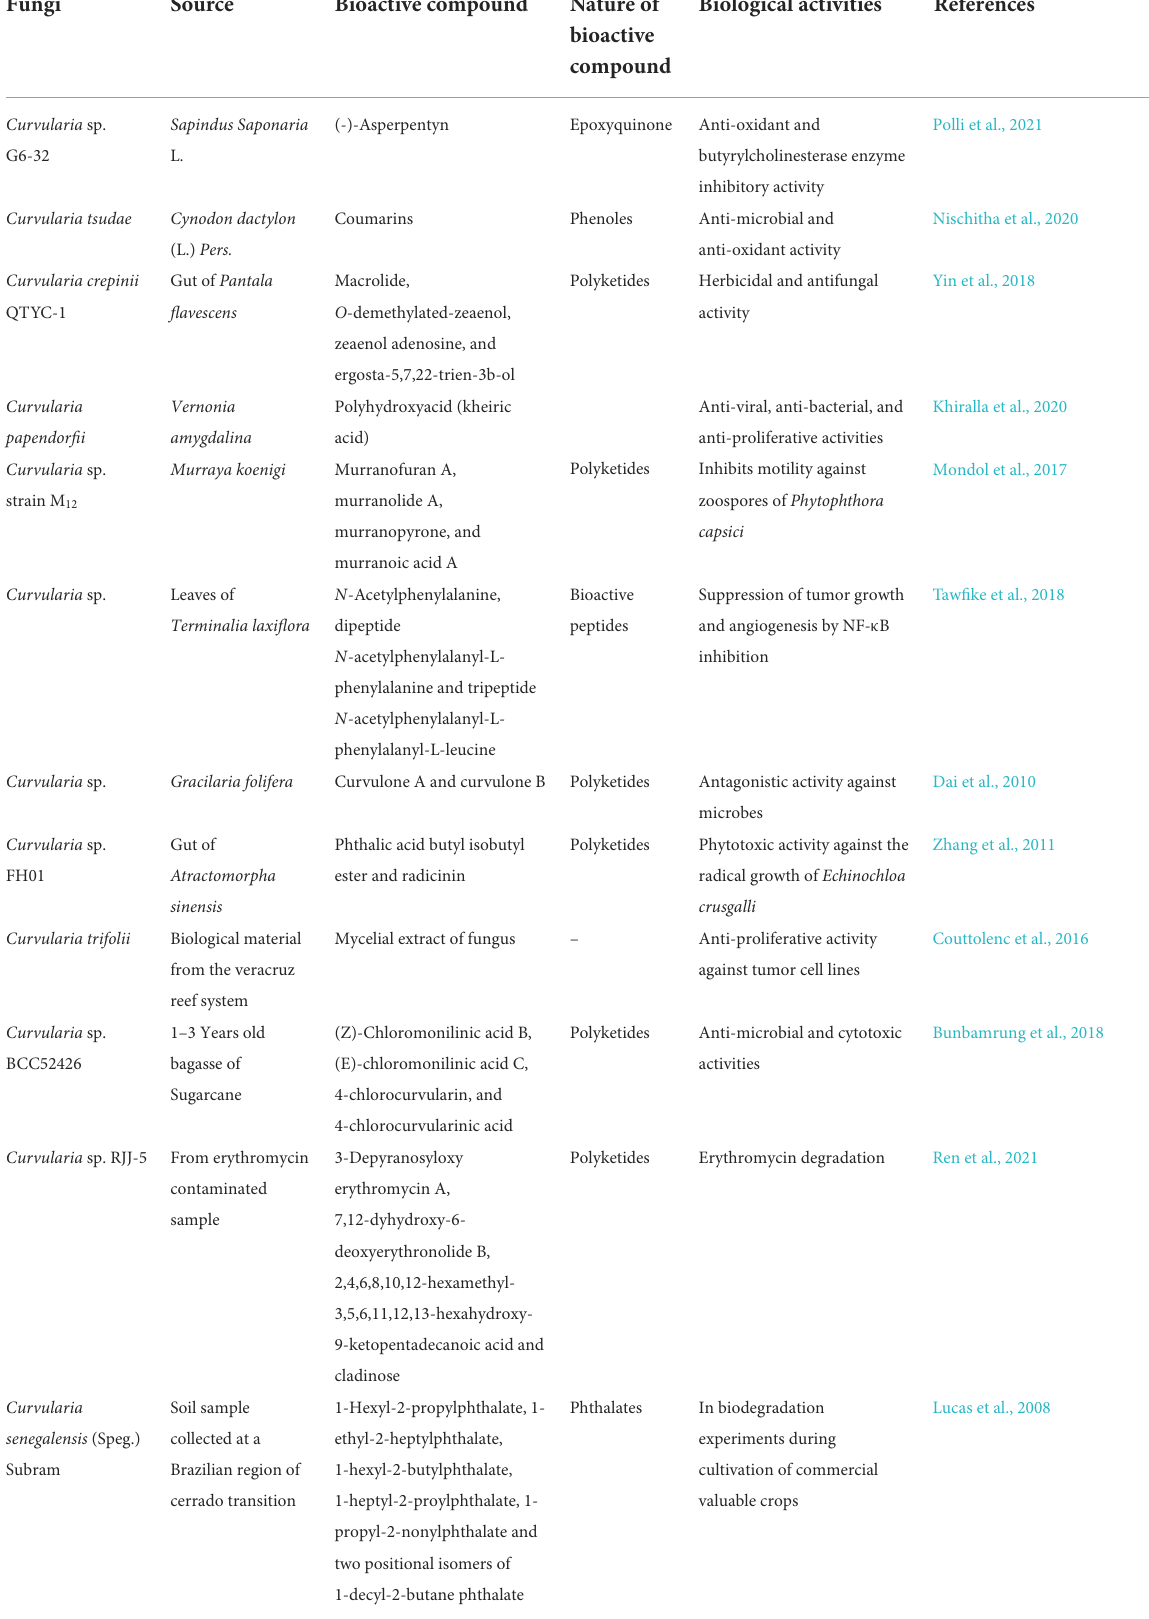
TABLE 1 Various sources and biological activities of bioactive compounds of Curvularia